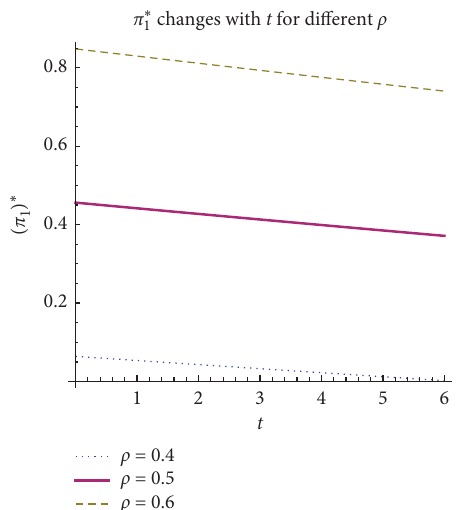
Figure 7: Values of π ∗